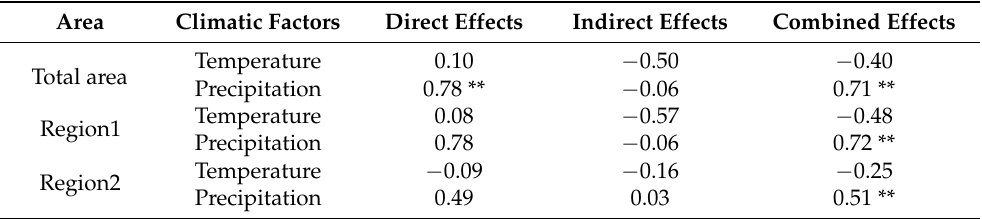
Table 1. Direct, indirect, and combined effects of temperature and precipitation on number of pixels with NDVI ≥ 0.1 in the growing